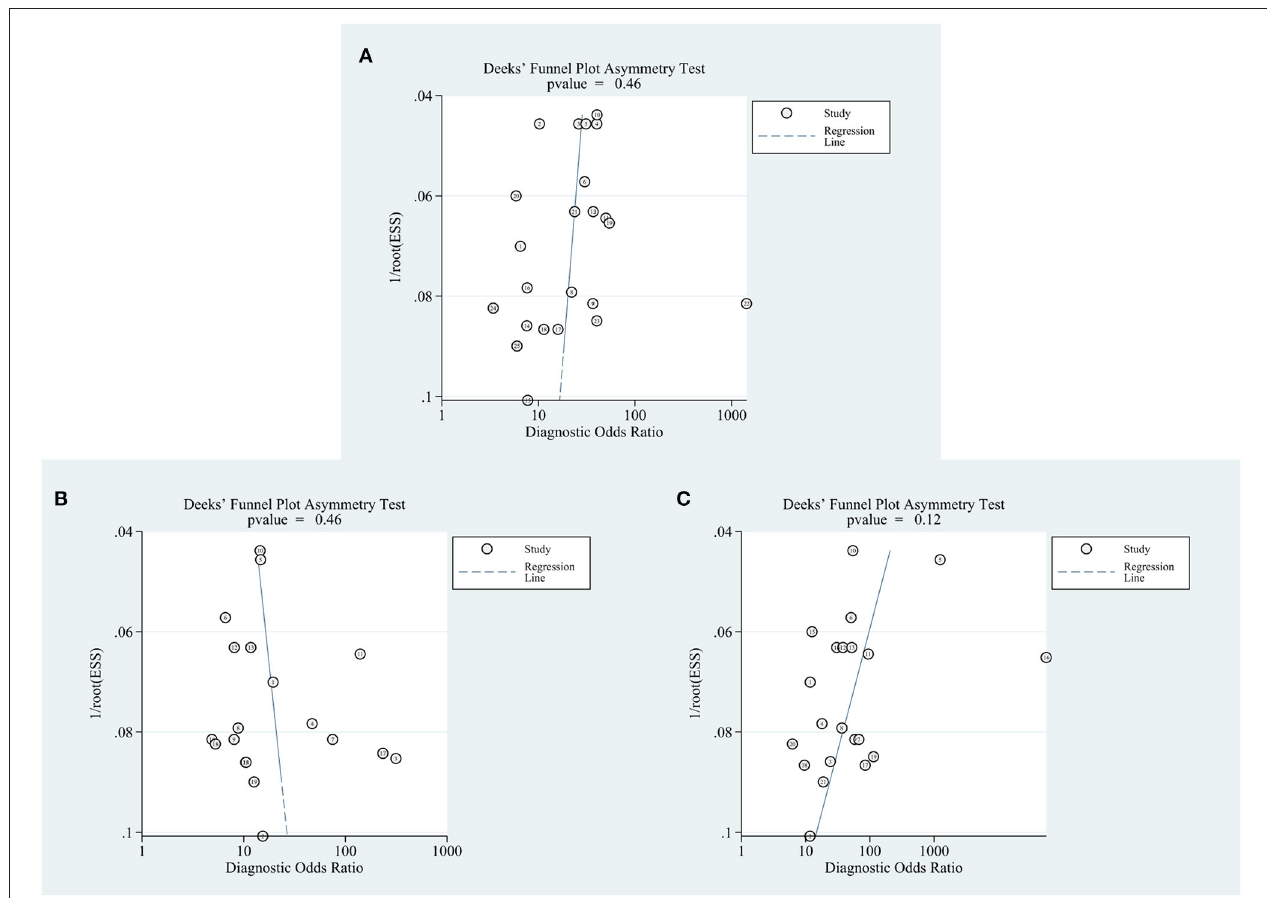
FIGURE 6 | Forest plots for publication bias. (A) circRNAs. (B) AFP. (C) Combination of circRNAs and